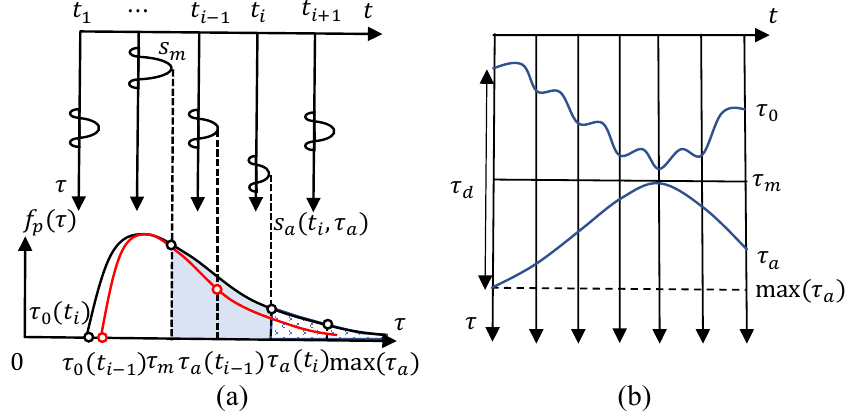
Figure 5. ( a ) mapping between s a and τ 0 ; ( b ) relations between τ 0 and τ d .